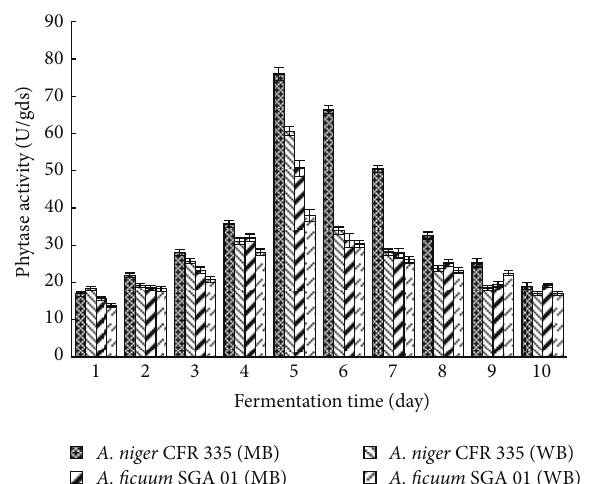
Figure7:Effectofvarioussolid-substratemediaonphytaseproduc- tion by Aspergillus niger CFR 335 and Aspergillus ficuum SGA 01 in submerged and solid-state